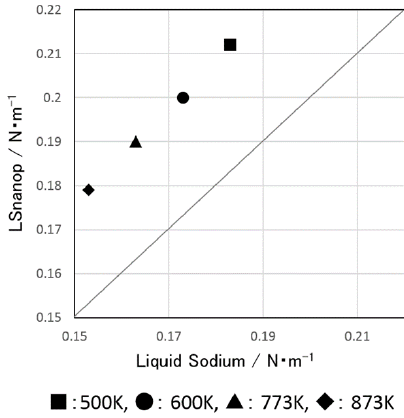
Figure 6. Comparison of the surface tensions of LSnanop and liquid Na: The slanted line corresponds to the hypothetical case in which the surface tensions of LSnanop and liquid Na are